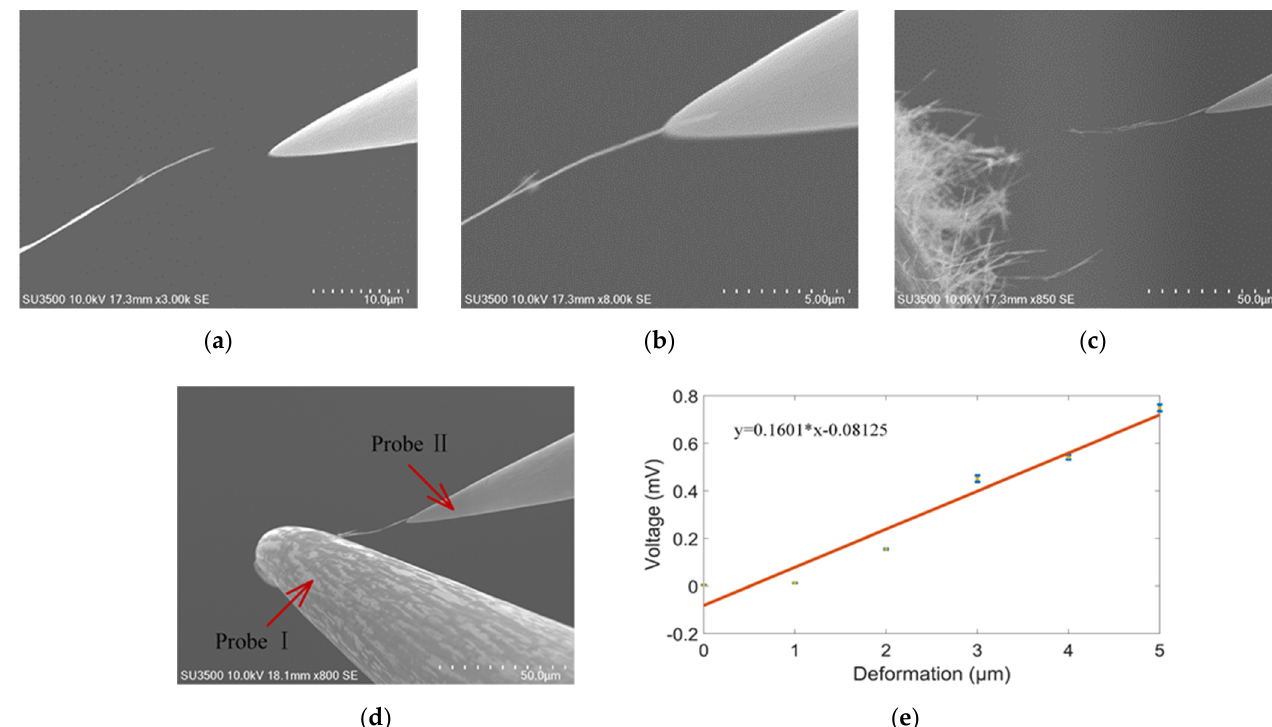
Figure 10. Piezoelectric characteristic measurement. ( a ) Probe Ⅱ gets close to ZnO nanowire. ( b ) Probe Ⅱ touches and picks up ZnO nanowire. ( c ) Probe Ⅱ takes the nanowire away from the tape. ( d ) Probe Ⅰ deforms the nanowire. ( e ) Piezoelectric voltage vs. deformation. Deformation ranges from 0 to 6 μ m. Accordingly, the output voltage varies from 0 to 0.74 mV. n = 15.